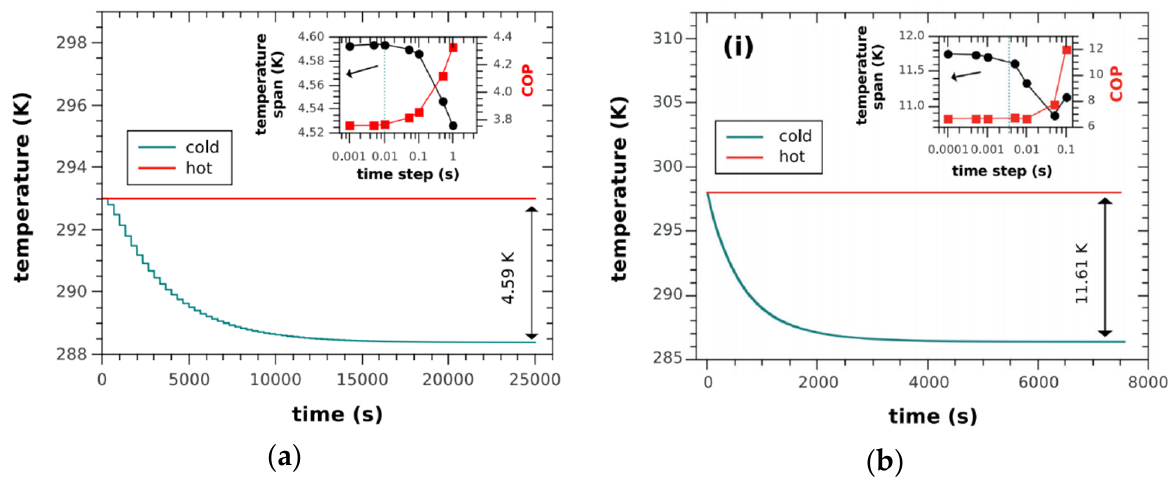
Figure 27. Temperature evolutions for the: ( a ) solid-state magnetocaloric system and ( b ) hydraulic AMRR system. An inset shows the evolution of the temperature range and the COP versus the time for the two systems [91].